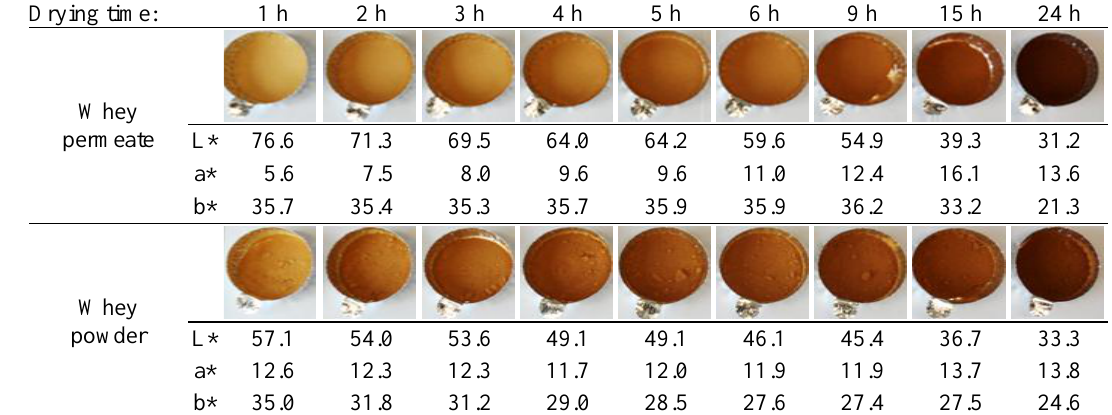
Figure 2. Color changes of whey permeate and whey powder dried at 125°C (Exp. 2). L*, lightness; a*, redness; b*, yellowness.